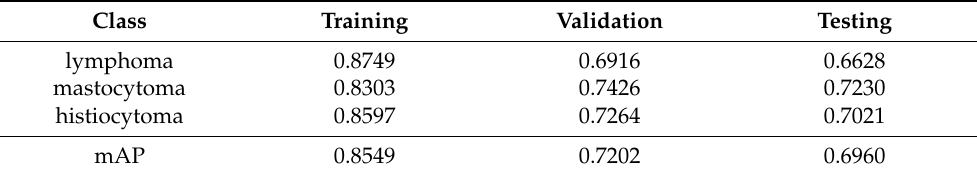
Table 3. Best model’s Average Precision for each class using ’divided’